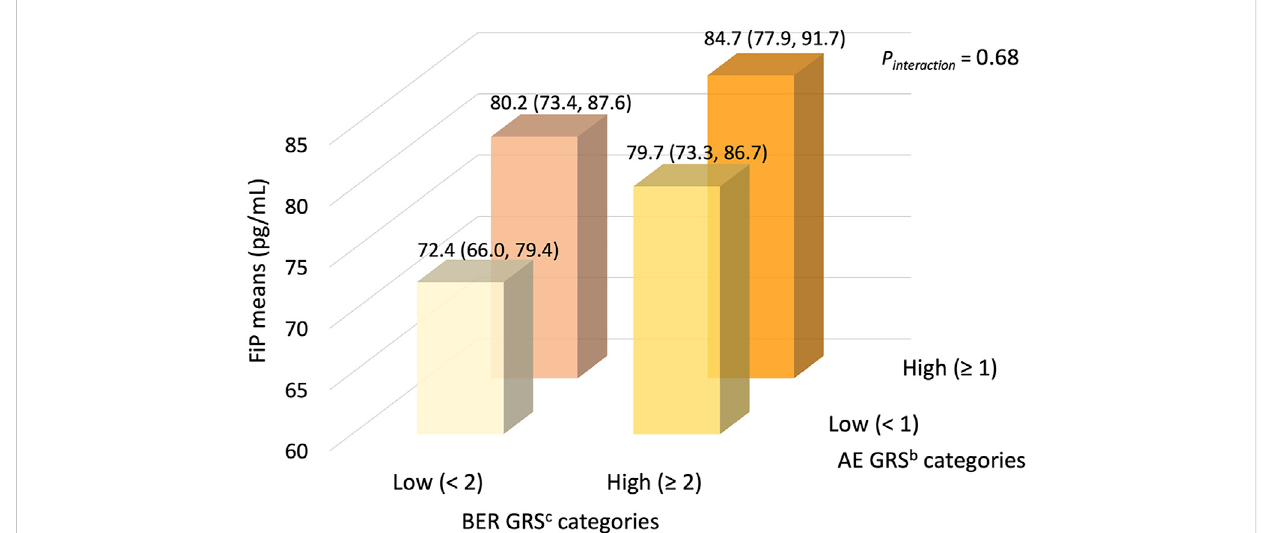
FIGURE 1 Mean a plasma F 2 -isoprostanes concentrations (95% CIs), according to joint dichotomized categories of antioxidant enzyme and DNA base excision repair GRS, in the pooled MAP I and MAP II cross-sectional studies ( n = 245). The joint lowest oxidative stress-speci fi c AE/BER GRS category ( n = 53) considered the reference group (the hypothesized lowest risk group). Compared to the reference group, the mean FiP concentrations in the joint low/ high ( n = 58), the joint high/low ( n = 53), and the joint high/high AE/BER GRS category ( n = 81) were, proportionately, 10.2% ( p = 0.13), 10.8% ( p = 0.12), and 16.4% ( p = 0.01) higher, respectively. Abbreviations: AE, antioxidant enzyme; BER, base excision repair; CI, con fi dence interval; FiP, plasma F 2 - isoprostanes concentration; GRS, genetic risk score; MAP, Markers of Adenomatous Polyps. a Geometric means (95% CIs), adjusted for sex and the oxidative balance score (OBS). b AE GRS based on 4 SNPs in the GSTP1 AE gene; see complete list of SNPs in the text and Supplementary Table S3. c BER GRS based on 12 SNPs in 5 BER genes; see complete list of genes and SNPs in the text and Supplementary Table